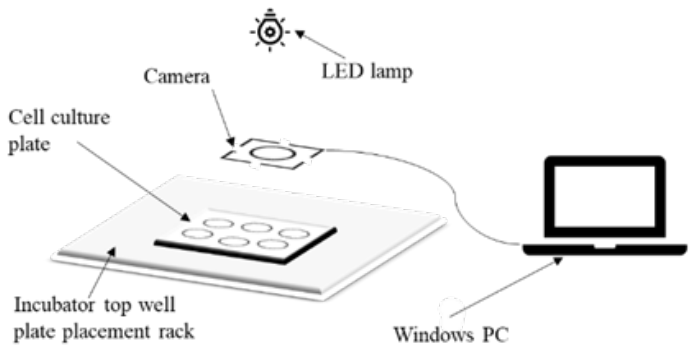
Figure 1. Schematic diagram of the orifice plate image acquisition